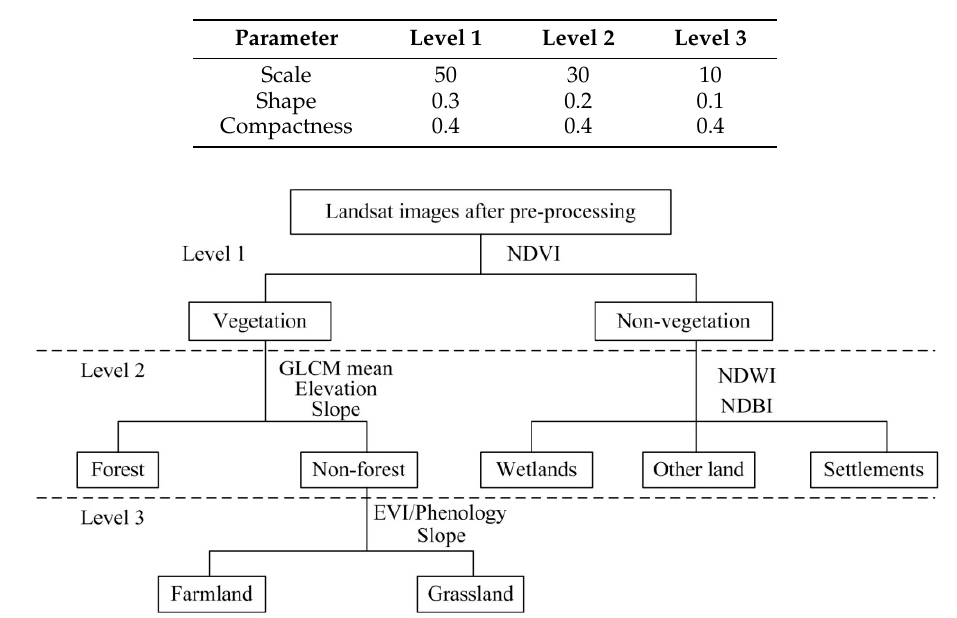
Table 2. Multi-scale segmentation parameters.